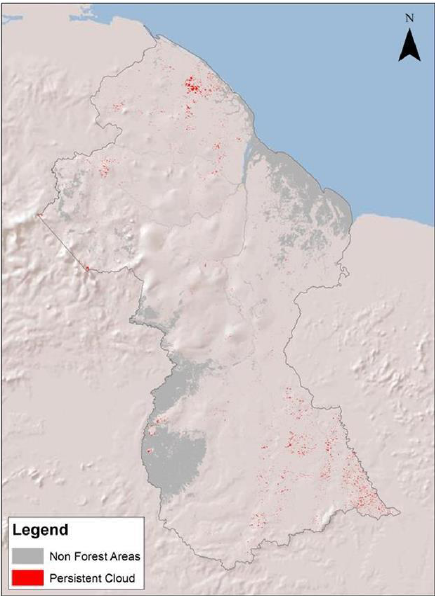
Figure 4: Persistent Cloud Cover © The Guyana Forestry Commission and Indufor